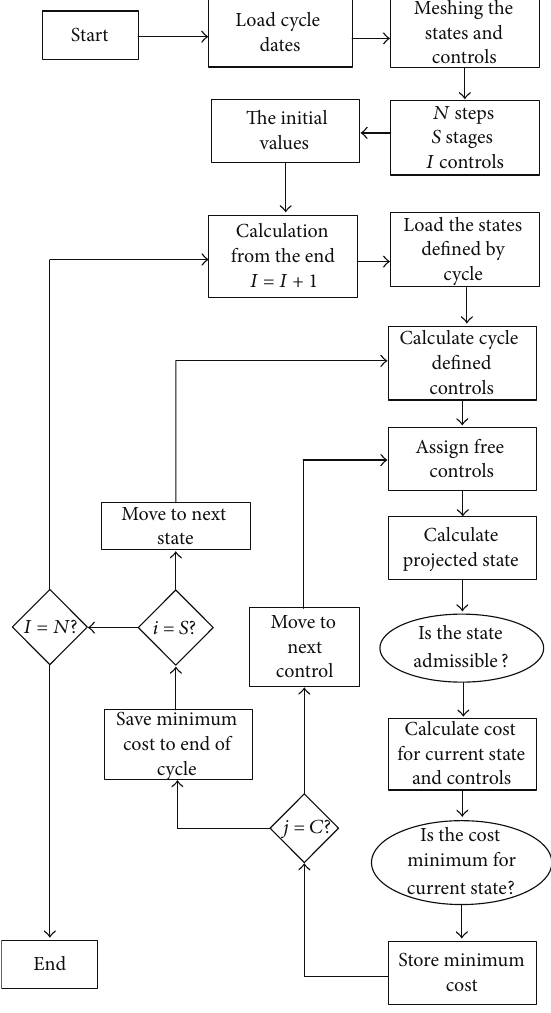
Figure 6: Flow chart of the